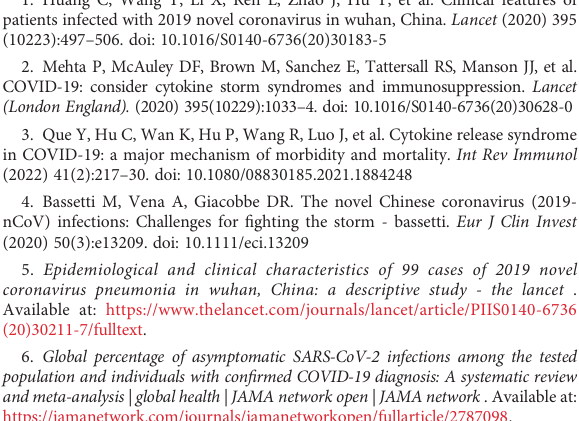
statistical signi fi cance was found among the represented conditions. SUPPLEMENTARY FIGURE 5 Flow cytometry gating strategy. (A) Representative scatter plots showing FSC-A x SSC-A gating to exclude debris based on size and granularity; (B) FSC-A x FSC-H to exclude doublets. (C) Zombie Aqua ™ fi xable viability marker to identify live cells (negative for the marker. (D) Staining with CD45 to identify hematopoietic cell linages. (E) Ly6G was used to identify neutrophils (as Ly6G + ). (F) Among the Ly6G - cells, CD11b x CD11c was used to identify alveolar macrophages and dendritic cells population (as CD11c + with variable levels of CD11b) and monocytes as long as other myeloid subsets (as CD11b + CD11c -/low ). Gates for all viability marker and all antibodies were determined using respective fl uorescence minus one (FMO) control. SUPPLEMENTARY FIGURE 6 (A) StringDB network (without inclusion of Hspa5) showing the associations between proteins differentially expressed in response to LPS challenge in mice lungs forming 4 principal clusters detected by an unsupervised Markov Cluster Algorithm (MCL). (B – E) Bar plots showing the Top-10 enriched Biological Processes associated with every cluster ordered by False Discovery Rate. Single bars indicate the number of proteins associated with every GOterm. SUPPLEMENTARY FIGURE 7 BiP Levels measured by proteomic analysis in lung tissues showing the mean ± SD of the scaled abundances. There were no statistically signi fi cant differences between samples for a One-Way ANOVA with a Tukey ’ s multiple comparisons test (n=4 for C- , 4-PBA and LPS + 4-PBA groups; n=3 for LPS